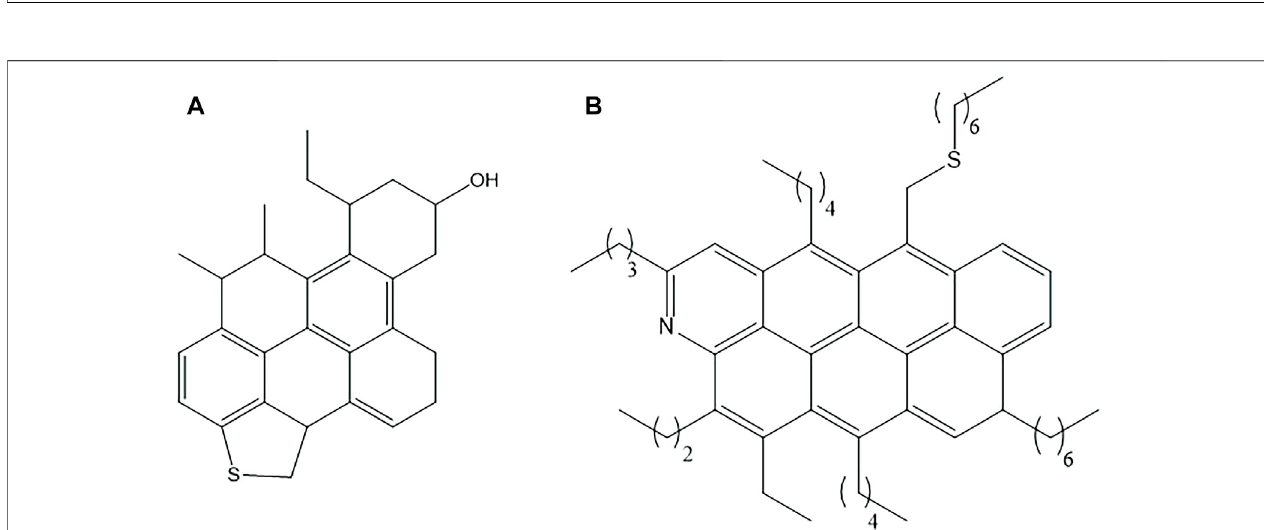
FIGURE 2 | Proposed structures of resins, adapted from (A) Abdel-Raouf (2012); (B) Akmaz et al. (2011).